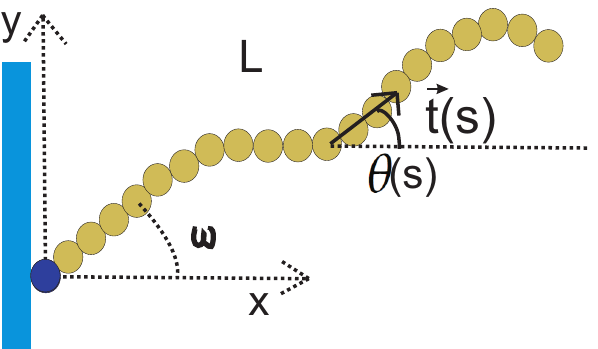
Figure 1. A typical configuration of a rather stiff grafted semiflexible filament. The persistence length of the filament is l p and it has contour length of L < l p . The filament is grafted in a substrate with grafting angle, ω .